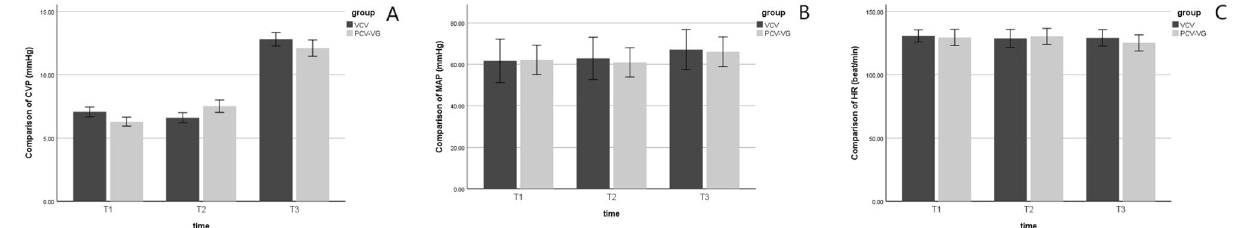
Figure 5. Comparison of haemodynamic variables at different time points. ( A ) CVP, central venous pressure; ( B ) MAP, mean arterial pressure; ( C ) HR, heart rate VCV, volume controlled ventilation; PCV-VG, pressure controlled volume guaranteed ventilation; T1, 10 min after induction of anaesthesia without pneumothorax; T2, 5 min after OLV commencement; T3, 5 min after complete CO 2